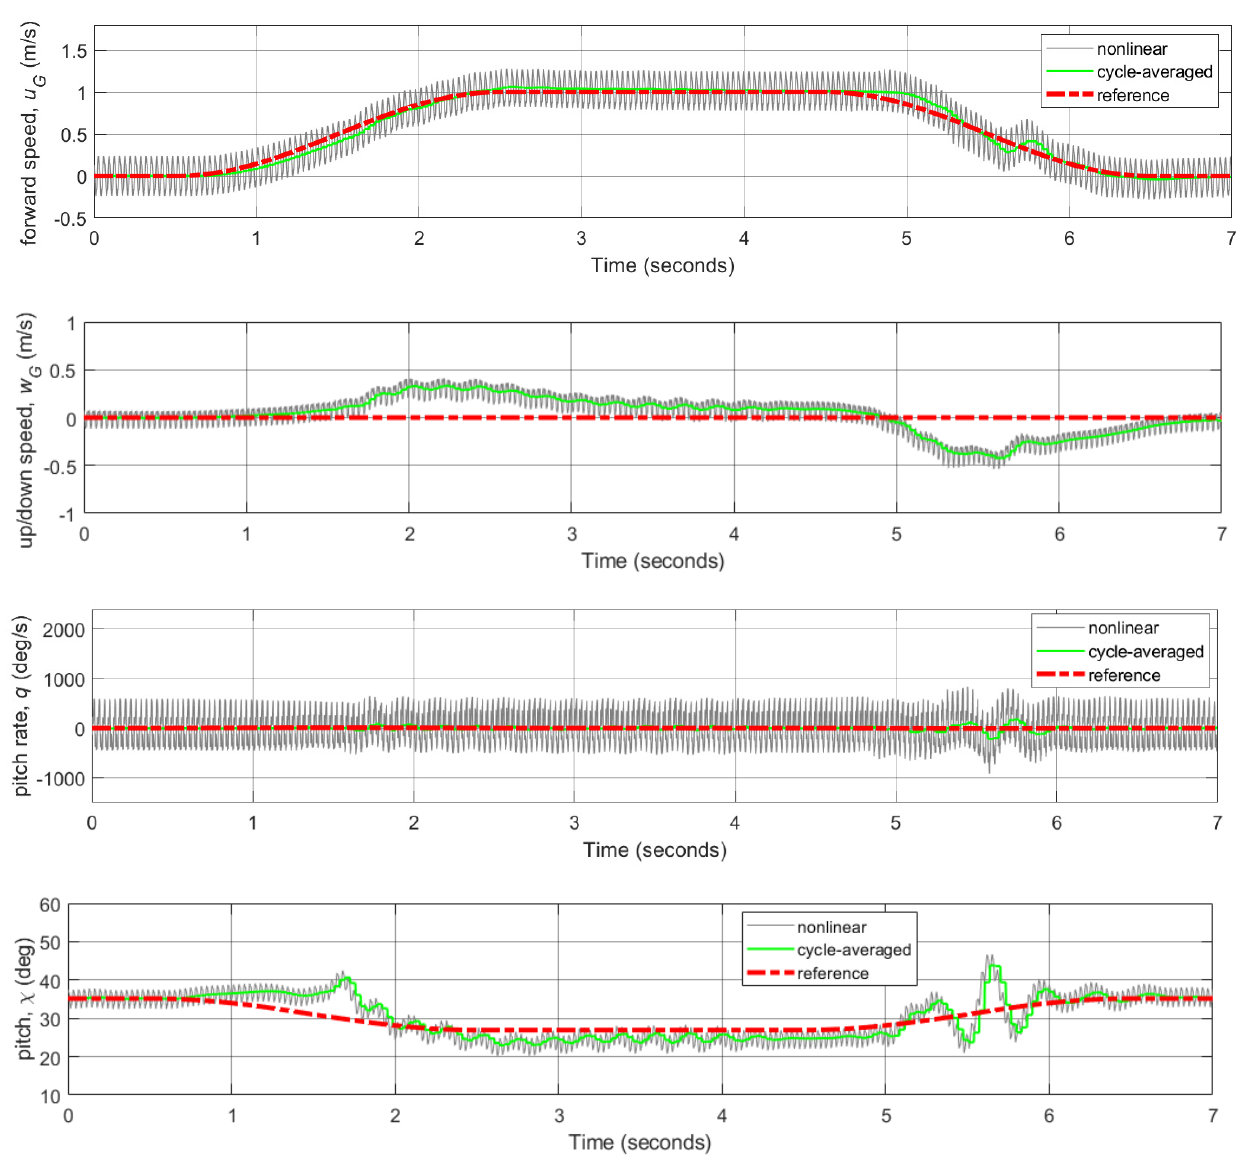
Figure 21. Flight control simulations for transition flight control of nonlinear FWMAV model.